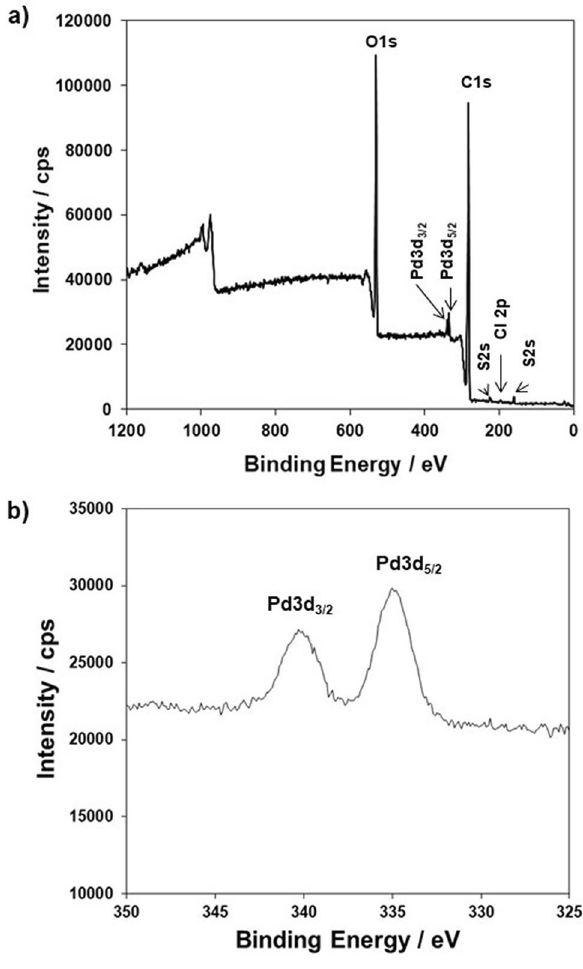
Figure 4. ( a ) Full-scan and ( b ) Pd 3d XPS spectra of Pd(II)-loaded 1 -EIR after Pd(II) adsorption.